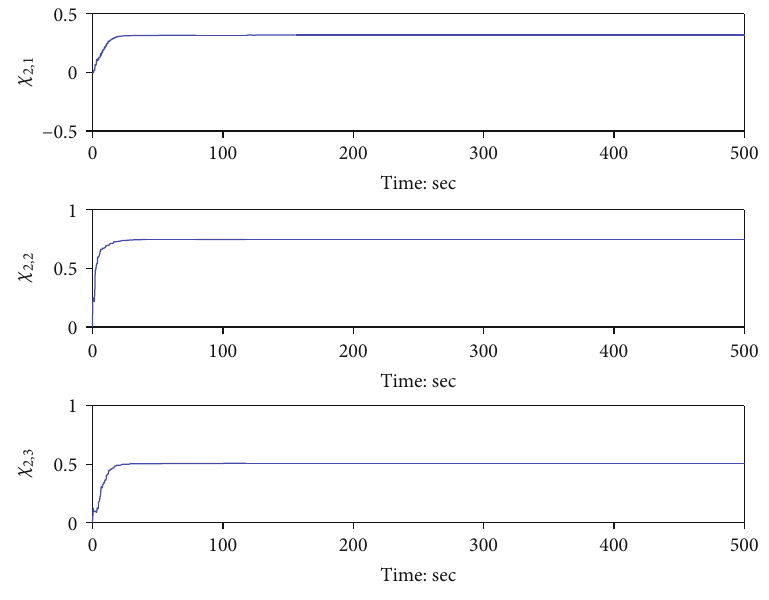
Figure 5: Parameter estimates χ